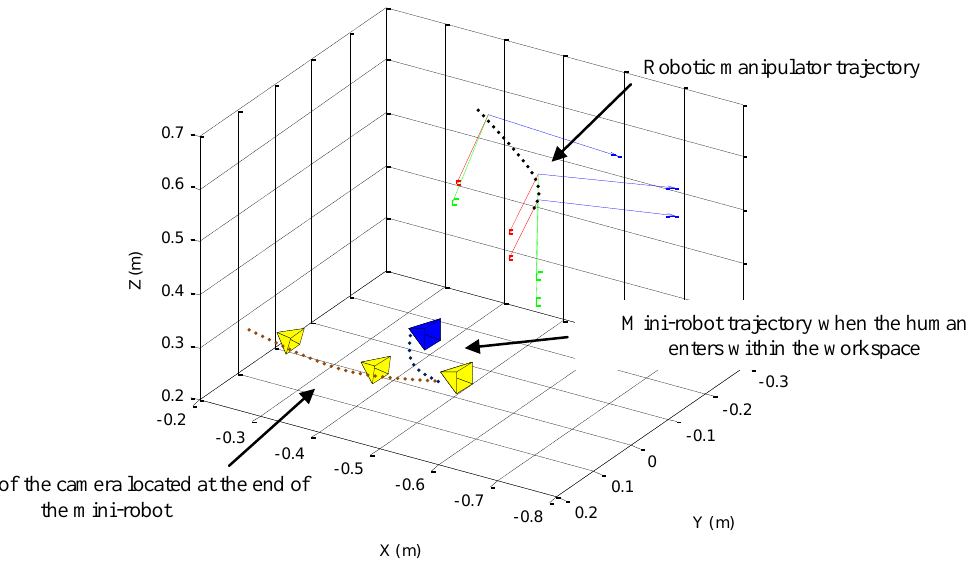
Figure 10. 3D trajectory of both robots during the second